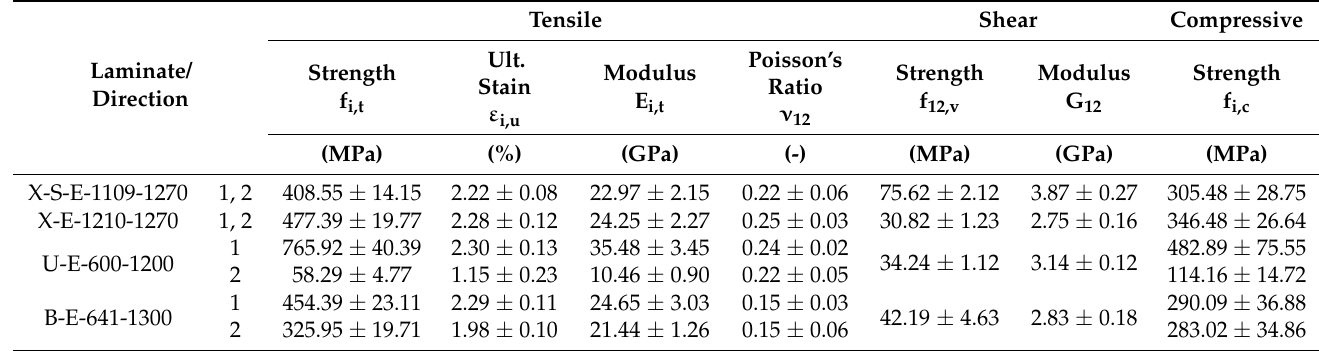
Table 5. Test results for target GFRP face laminate.